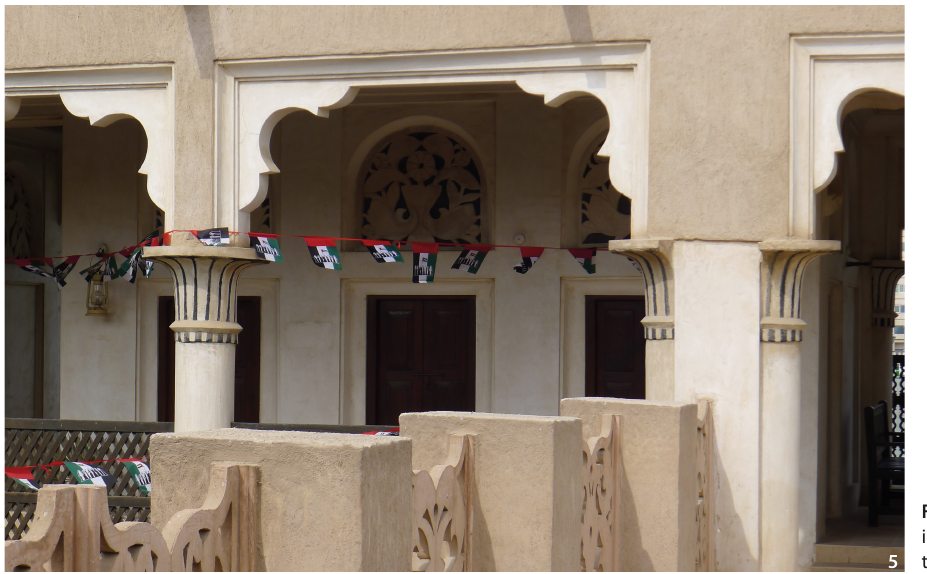
Figure 5 Celebrating National Day in a restored House, 2012 (Source: the author).